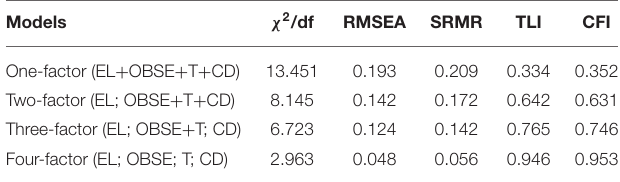
TABLE 1 | Results of confirmatory factor